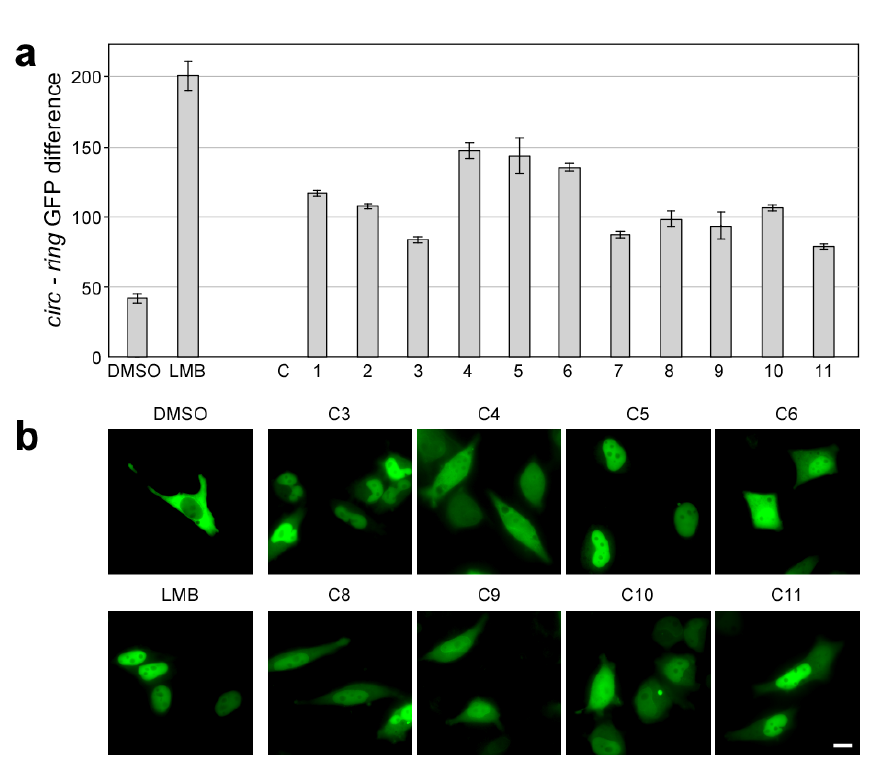
Figure 6. (a) Secondary ArrayScan ® -based validation of potential export antagonists. cells/well were seeded into 384-well plates. 16 h later, cells were treated 1 × 10 4 A431 bio with LMB (10nM), DMSO or the indicated compounds (C1-C11; 25 µM) for 5 h, and translocation was quantitated using the Cellomics ArrayScan ® VTI imager. The CIRC- RING differences are indicative of efficient export inhibition. Columns, mean; bars, SD. (b) In lab verification of hit compound performance in living HeLa cells transiently expressing the RevNES biosensor. Indicated compounds were applied at a concentration of 25 µM for 5 h, resulting in efficient nuclear accumulation of the biosensor. Scale bar, 10 μ m. (c) Compound specific kinetics of inhibition. HeLa cells transiently expressing the RevNES biosensor were treated with LMB (10nM) or the indicated compounds (25 µM). The localization of the biosensor is shown at the indicated time points when the compounds displayed their maximum inhibitory activity (top panel), as well as 24 h post treatment. The inhibitory activity of C3 and C11 was reversed after 24 h. Scale bar, 10 μ m. (d) Kinetic activity profile of export inhibitors. Selection of different time points (indicated by the arrows) for snapshot analysis (highlighted in grey) may significantly influence the number and type of compounds identified in primary screens. A continuous kinetic monitoring of the biosensor translocation may ensure the identification of the maximum number of bioactive substances and the optimal extraction of informations concerning their bioactivity. Time point used for analysis of the primary RevNES-biosensor screen is marked by the asterisks. An optimal kinetic window is highlighted in